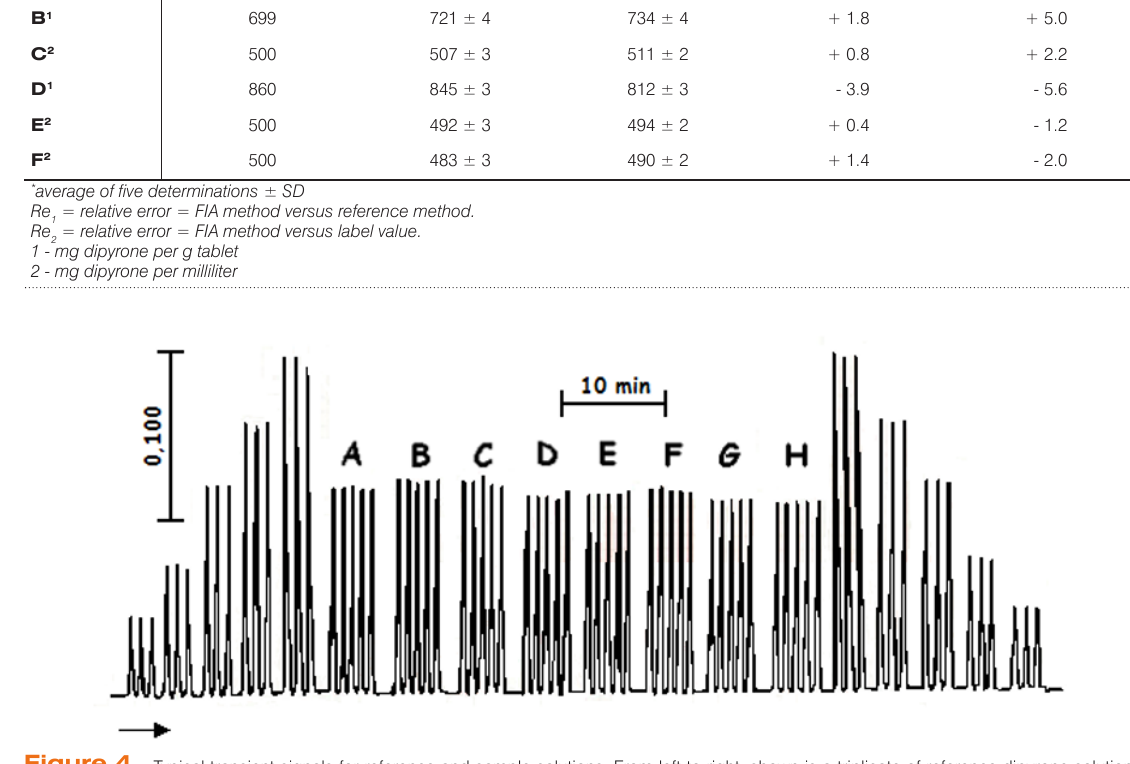
Figure 4. Typical transient signals for reference and sample solutions. From left to right, shown is a triplicate of reference dipyrone solutions in the concentration range of 5.0×10 -5 to 4.0×10 -4 mol L -1 , eight pharmaceutical sample solutions (A, B, C, D, F, G and H) and triplicate of reference dipyrone solutions again. Experimental conditions reported on Fig. 1